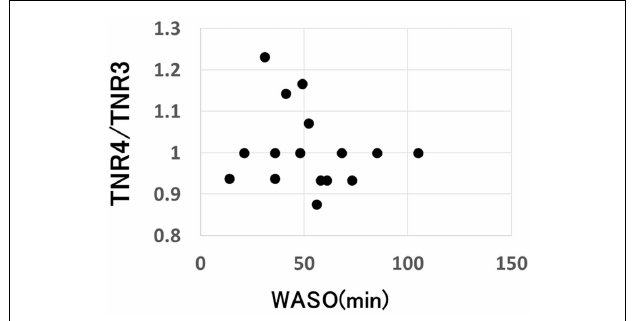
FIGURE 5 | Correlation between the change in the total number of recall and the amount of nocturnal waking, as represented byWASO (wake after sleep onset) in the sleep group ( p = 0.31) .